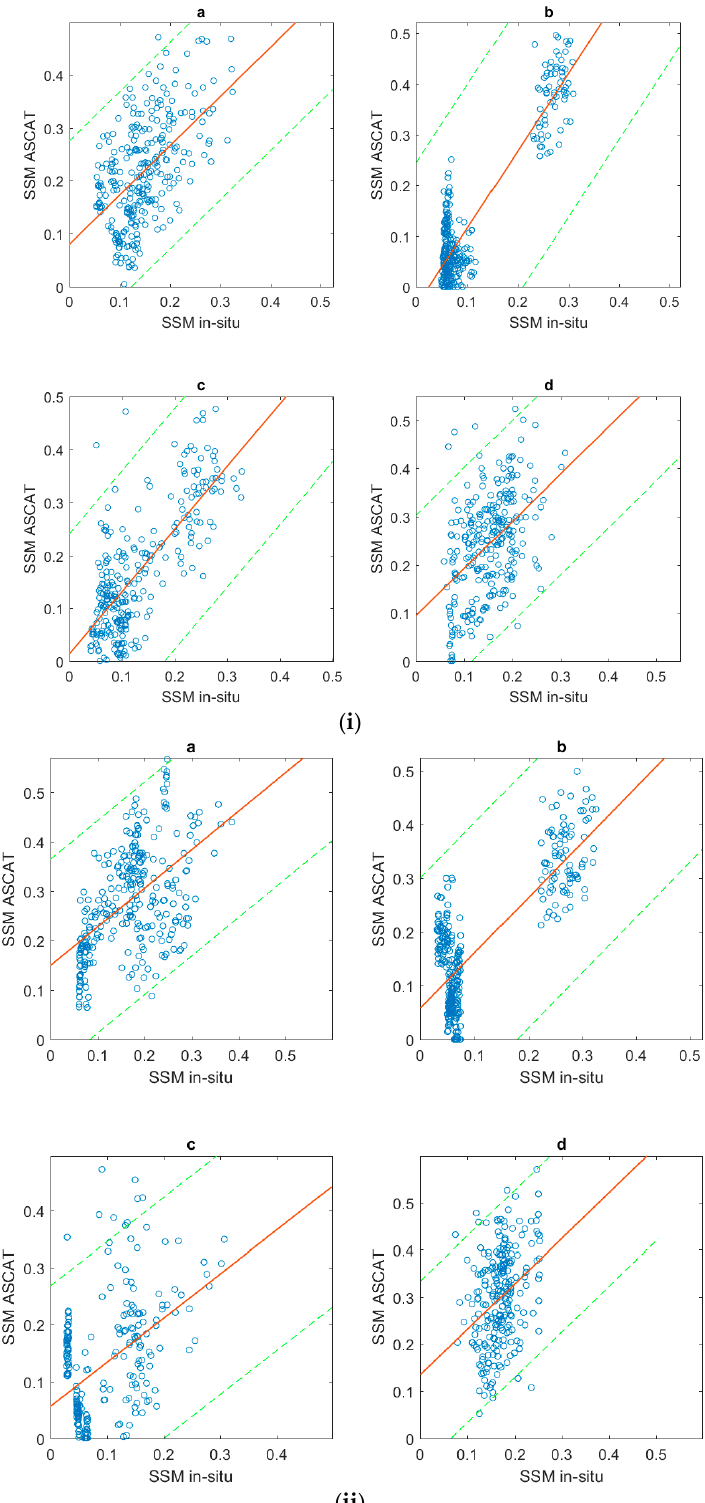
Figure 13. Scatter diagram of in situ and predicted SM from ASCAT 25Km for the different seasons for all sites together shown here for year ( i ) 2010 and ( ii ) 2011. For all sites in AUSTRALIA ( a ) Autumn, ( b ) Winter, ( c ) Spring, and ( d ) Summer. The green dashed lines represent the 95% confidence level.